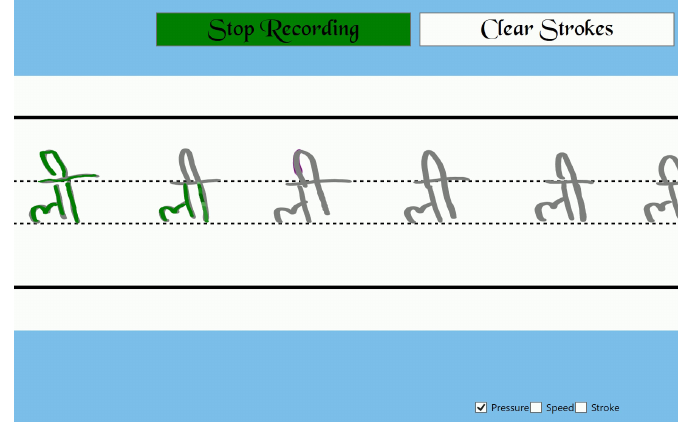
Figure 3. Pressure feedback with saturation.